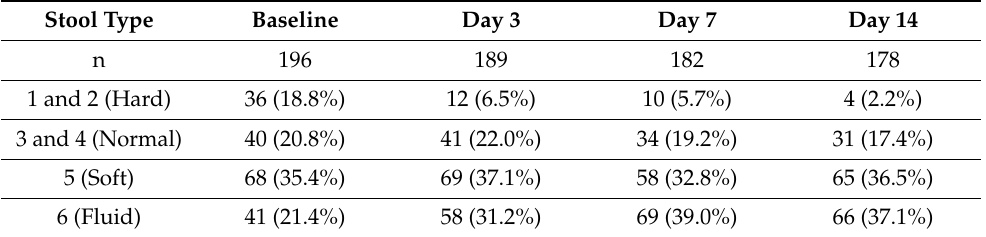
Table 6. Evolution of CoMiSS per time point for stool